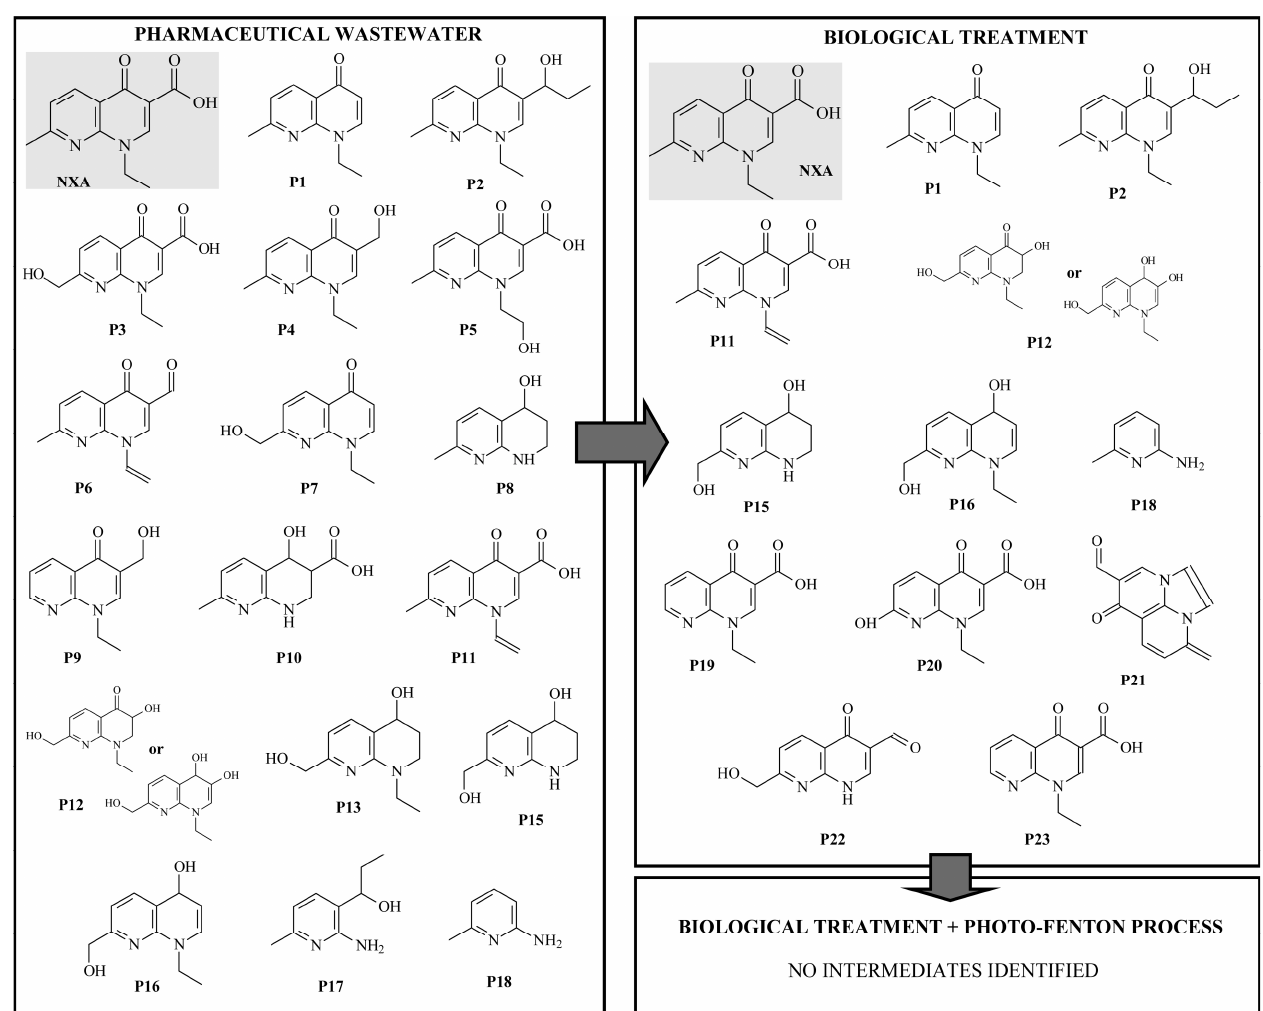
Figure 3. Nalidixic acid and transformation products identified during the treatment of pharmaceutical wastewater (Reprinted from [38], with permission of American Chemical Society, 2009). Table 5. Hybrid systems (coupling of homogeneous/heterogeneous photocatalysis with other pro- cesses) for the treatment of pharmaceutical industry wastewaters.